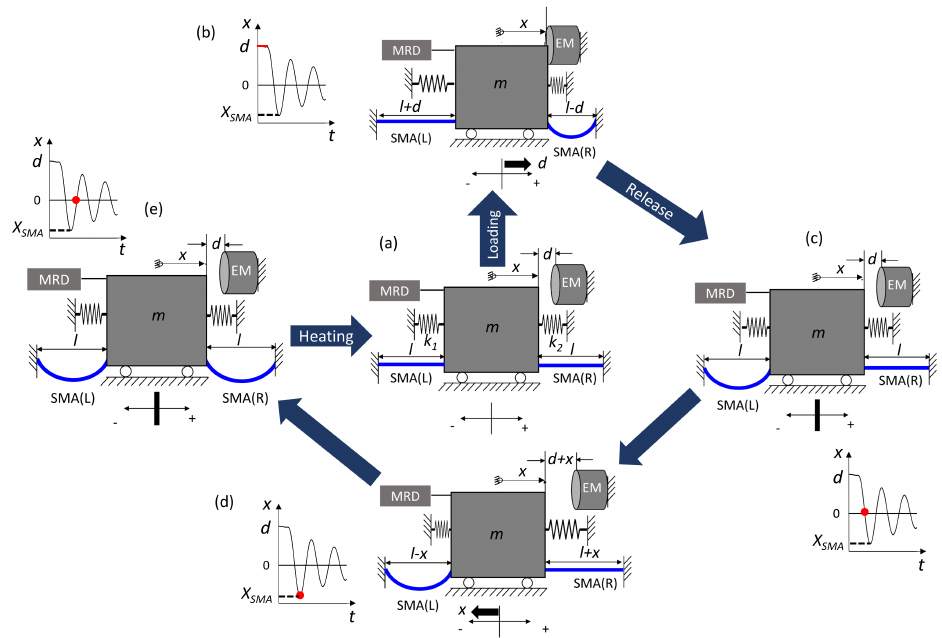
Figure 9. Illustration of operation cycle of experimental